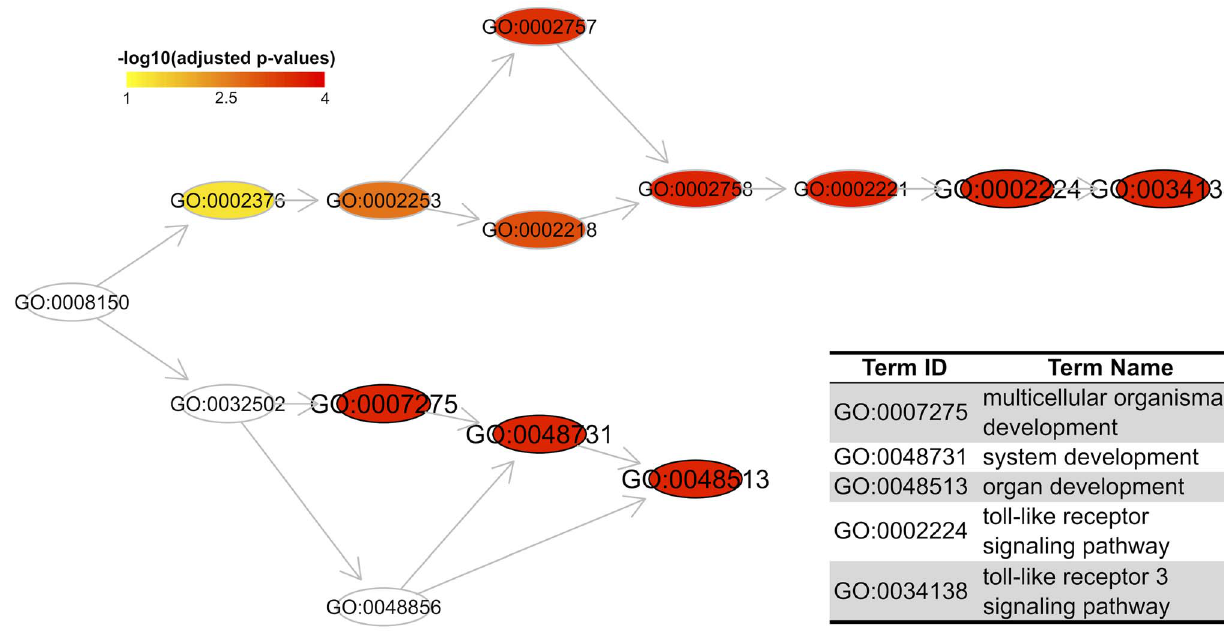
Figure 1. Domain-based enrichment analysis using GOBP terms. Only the most significant 5 terms/nodes (outlined in black; explained in the bottom-right panel) are visualised along with their ancestral terms. Nodes are coloured according to adjusted p-values.